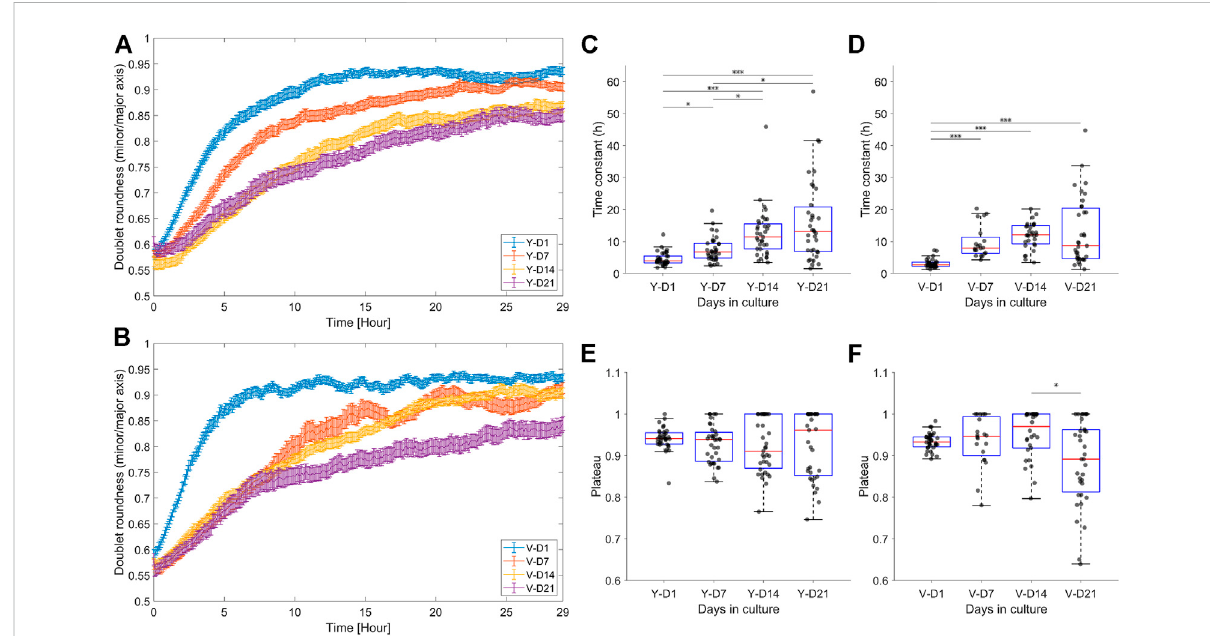
FIGURE 6 Dynamic response of the doublet roundness and the distribution of the extracted fusion parameters. (A,B) Average response ±SEM of the doublet roundness for the different levels of maturation, respectively, for the Y and V pools. (C,D) Box plot of the fusion rate parameter, i.e., the time constant, respectively, for the Y and V pools. (E,F) Box plot of the fusion quality parameter, i.e., the plateau, respectively, for the Y and V pools. Data were compared with Kruskal – Wallis and Dunn – Sidak post hoc tests. Signi fi cance was visualized with * p < 0.05; ** p < 0.01; *** p <